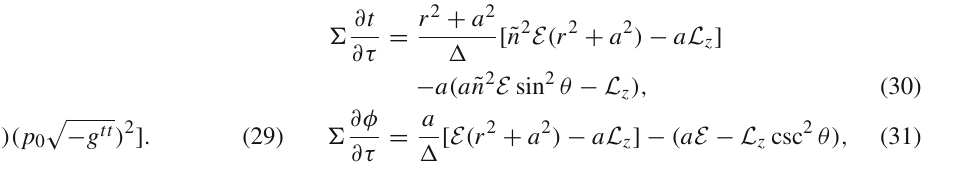
Fig. 5 Analysis of the observables corresponding to π/ 2